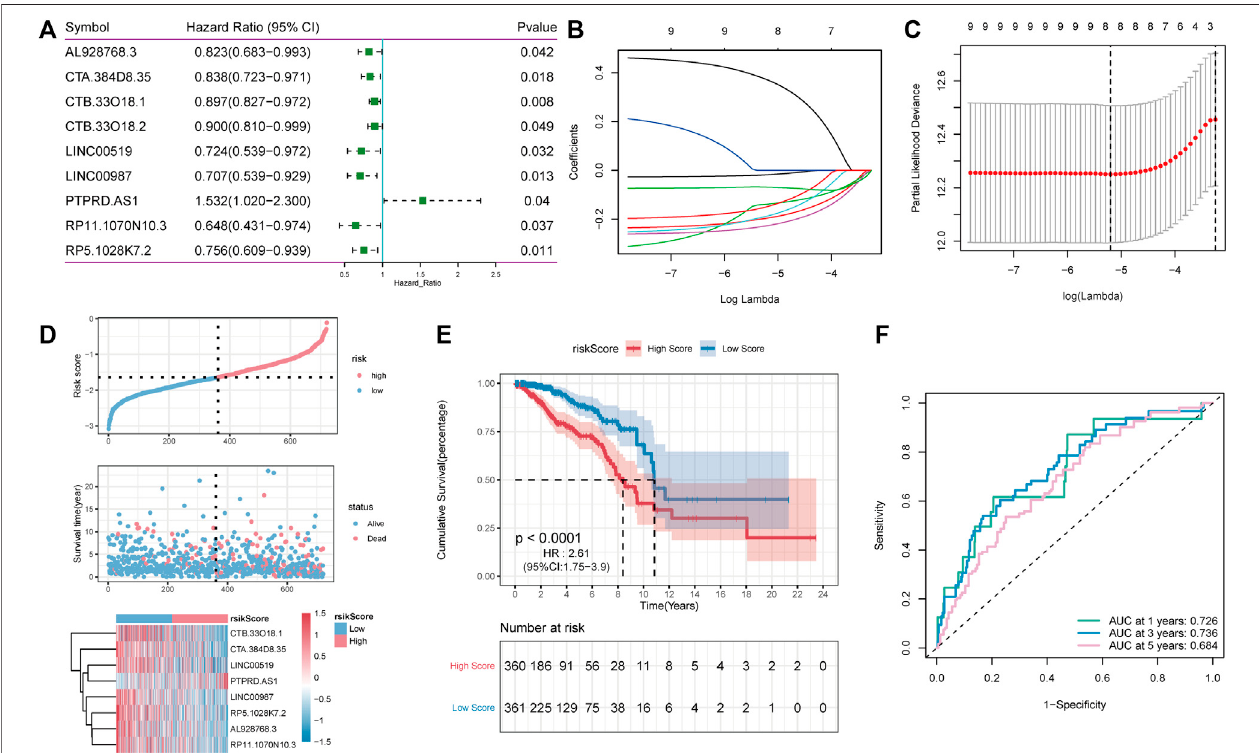
FIGURE5| LncRNAScreeningandconstructionofriskmodel. (A) :One-waycoxscreeningfor9lncRNAs; (B) :Thechangetrajectoryofeachindependentvariable, with the horizontal axis representing the log value of the independent variable lambda and the vertical axis representing the coef fi cient of the independent variable; (C) Con fi dence interval under each lambda; (D) : Distribution diagram of risk score; (E) : OS curves for the different RP-score subgroups with the cut-off value; (F) : The time- dependent receiver operating characteristic (ROC) analysis of the RP-score. The area under the curve (AUC) was 0.726, 0.736, 0.684 at 1, 3, and 5 years,